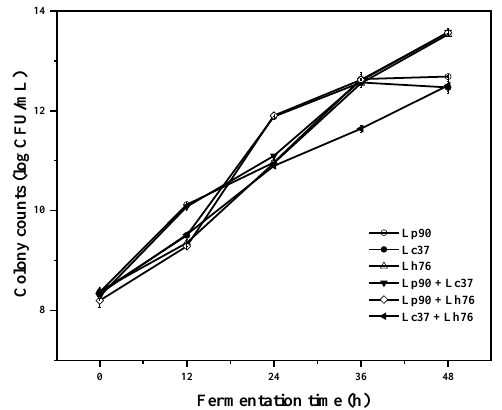
Figure 1. Colony counts of monoculture and binary mixture of lactic acid bacteria in pear juice during fermentation. Abbreviations: Lp90, Lactiplantibacillus plantarum 90; Lc37, Lacticaseibacillus casei 37; Lh76, Lactobacillus helveticus 76; Lp90 + Lc37, mixture of Lactiplantibacillus plantarum 90 and Lacticaseibacillus casei 37; Lp90 + Lh76, mixture of Lactiplantibacillus plantarum 90 and Lactobacillus helveticus 76; Lc37 + Lh76, mixture of Lacticaseibacillus casei 37 and Lactobacillus helveticus 76.